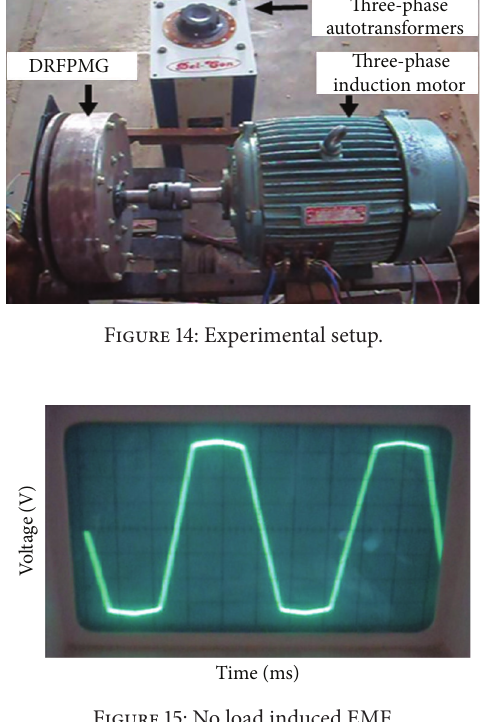
Figure 15: No load induced EMF.